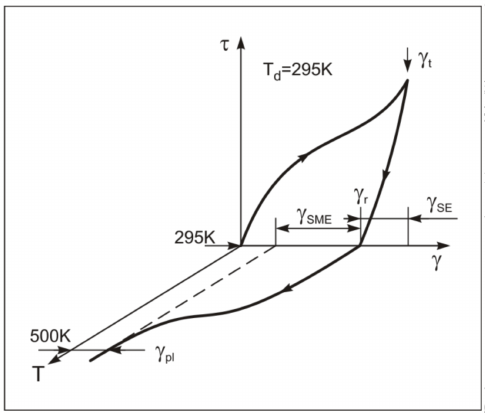
Figure 2. The accumulation and recovery of strain in isothermal (T d = 295 K) cycle “ τ - γ ” and during the subsequent heating of unloaded specimens